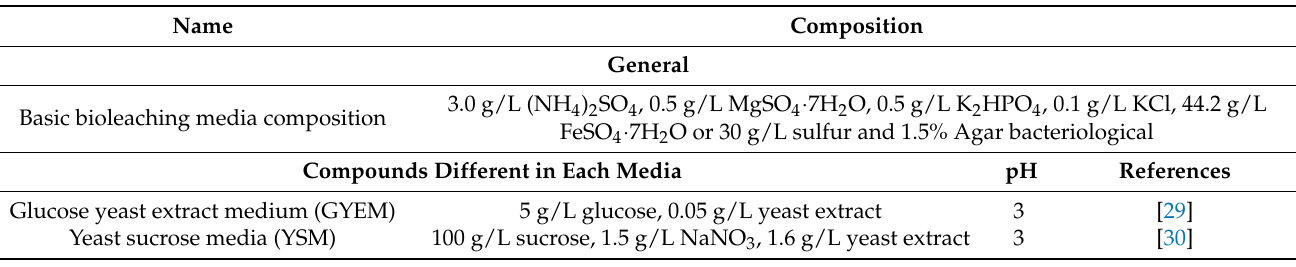
Table 1. Media composition for enrichment and isolation of bioleaching microorganisms.